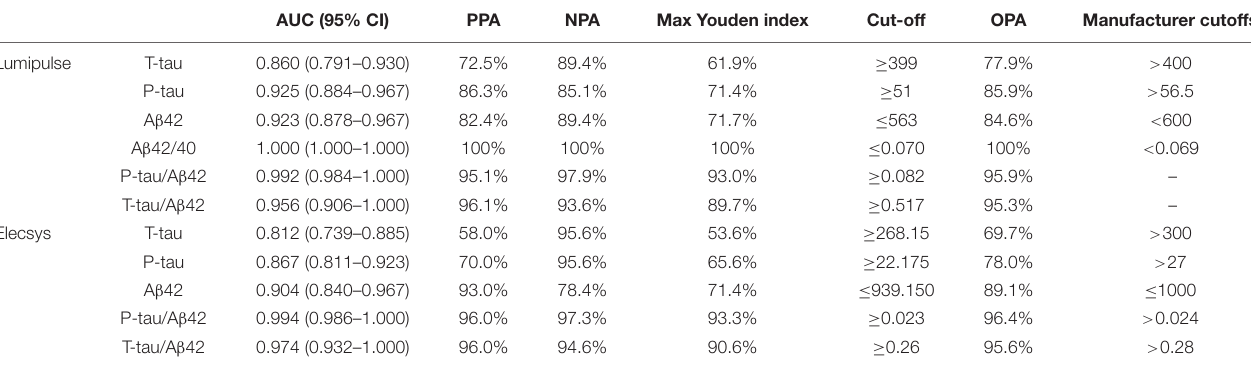
AUC, Area under the curve. *The percentage of correct classification of AD + correct classification of non-AD/all cases. **Values of | z| < 1.96 were taken as evidence that the true ROC areas were not different. TABLE 4 | Cut-offs of CSF biomarkers that yielded maximum Youden index versus A β 42/A β 40 ratio status in the receiver operating characteristics